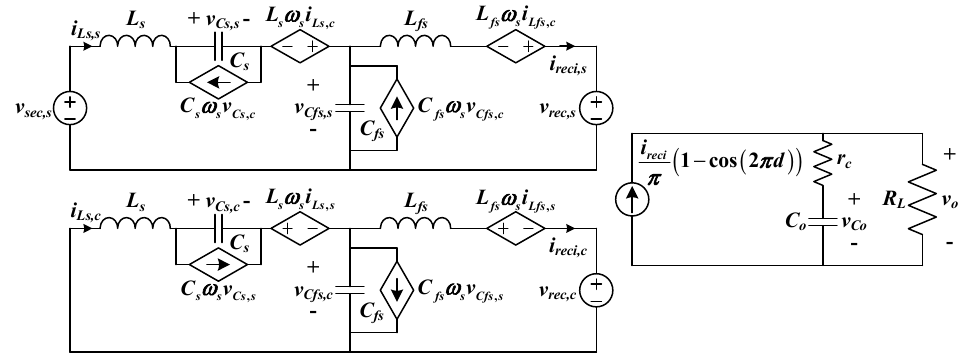
Figure 6. Nonlinear large-signal equivalent circuit.